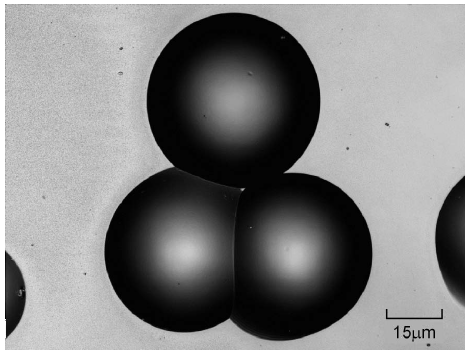
Fig. 4. Example showing variation in track diameter. Image ob- tained using a × 50